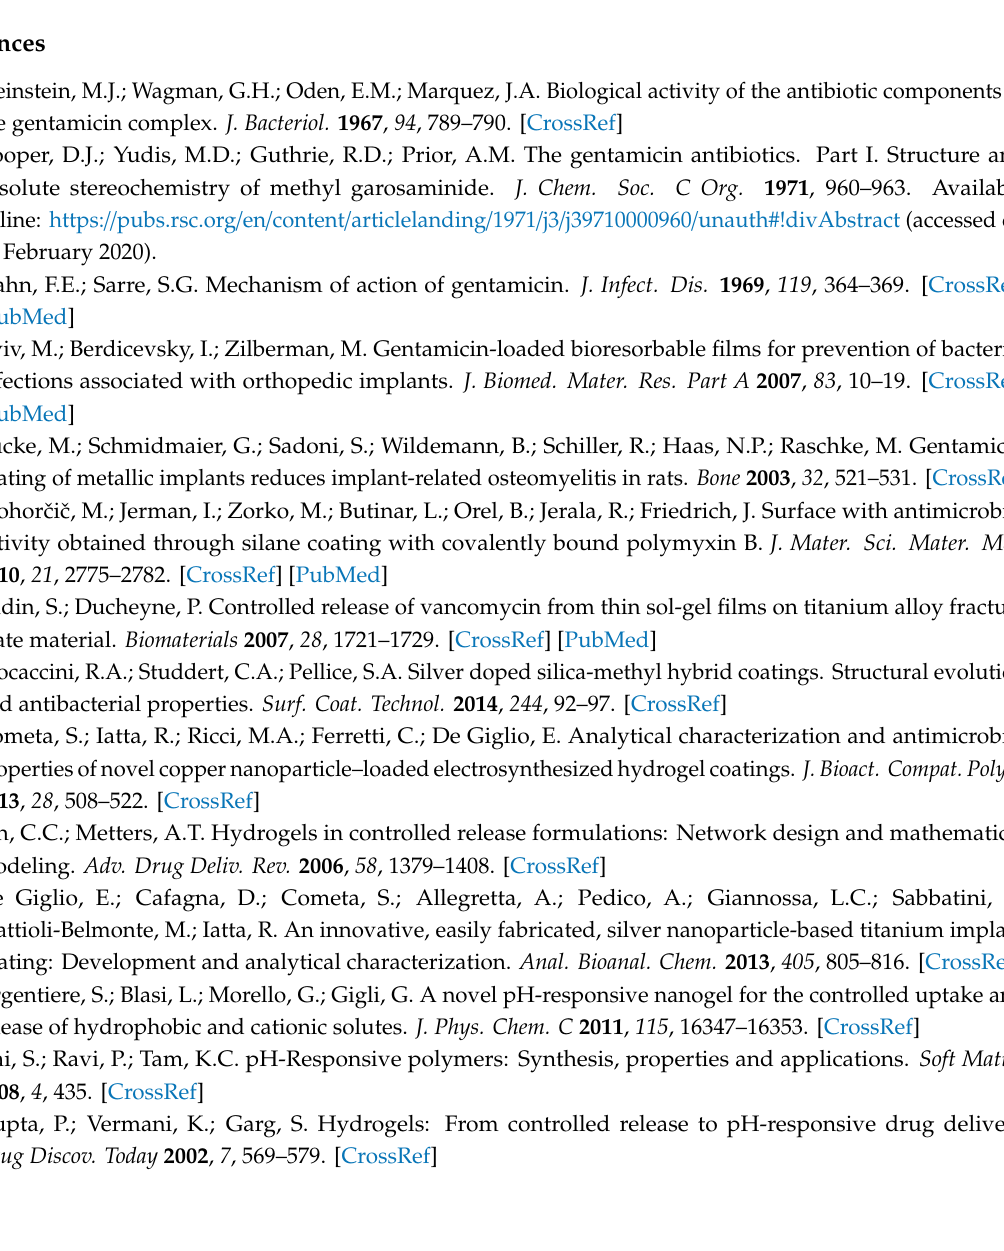
Figure S1: FTIR spectrum of iCVD MAA / EGDMA copolymer with 46% crosslinker, Figure S2: Example of the best fitting of the infrared spectrum of an iCVD MAA-EGDMA (85%) copolymer Table S1: Thickness of drug layer deposited by drop casting or spin coating, Figure S3. Calibration curve of electrochemical impedance spectroscopy (EIS) conductivity measurement of gentamicin, and corresponding fitting, Figure S4. Gentamicin release from drop casted